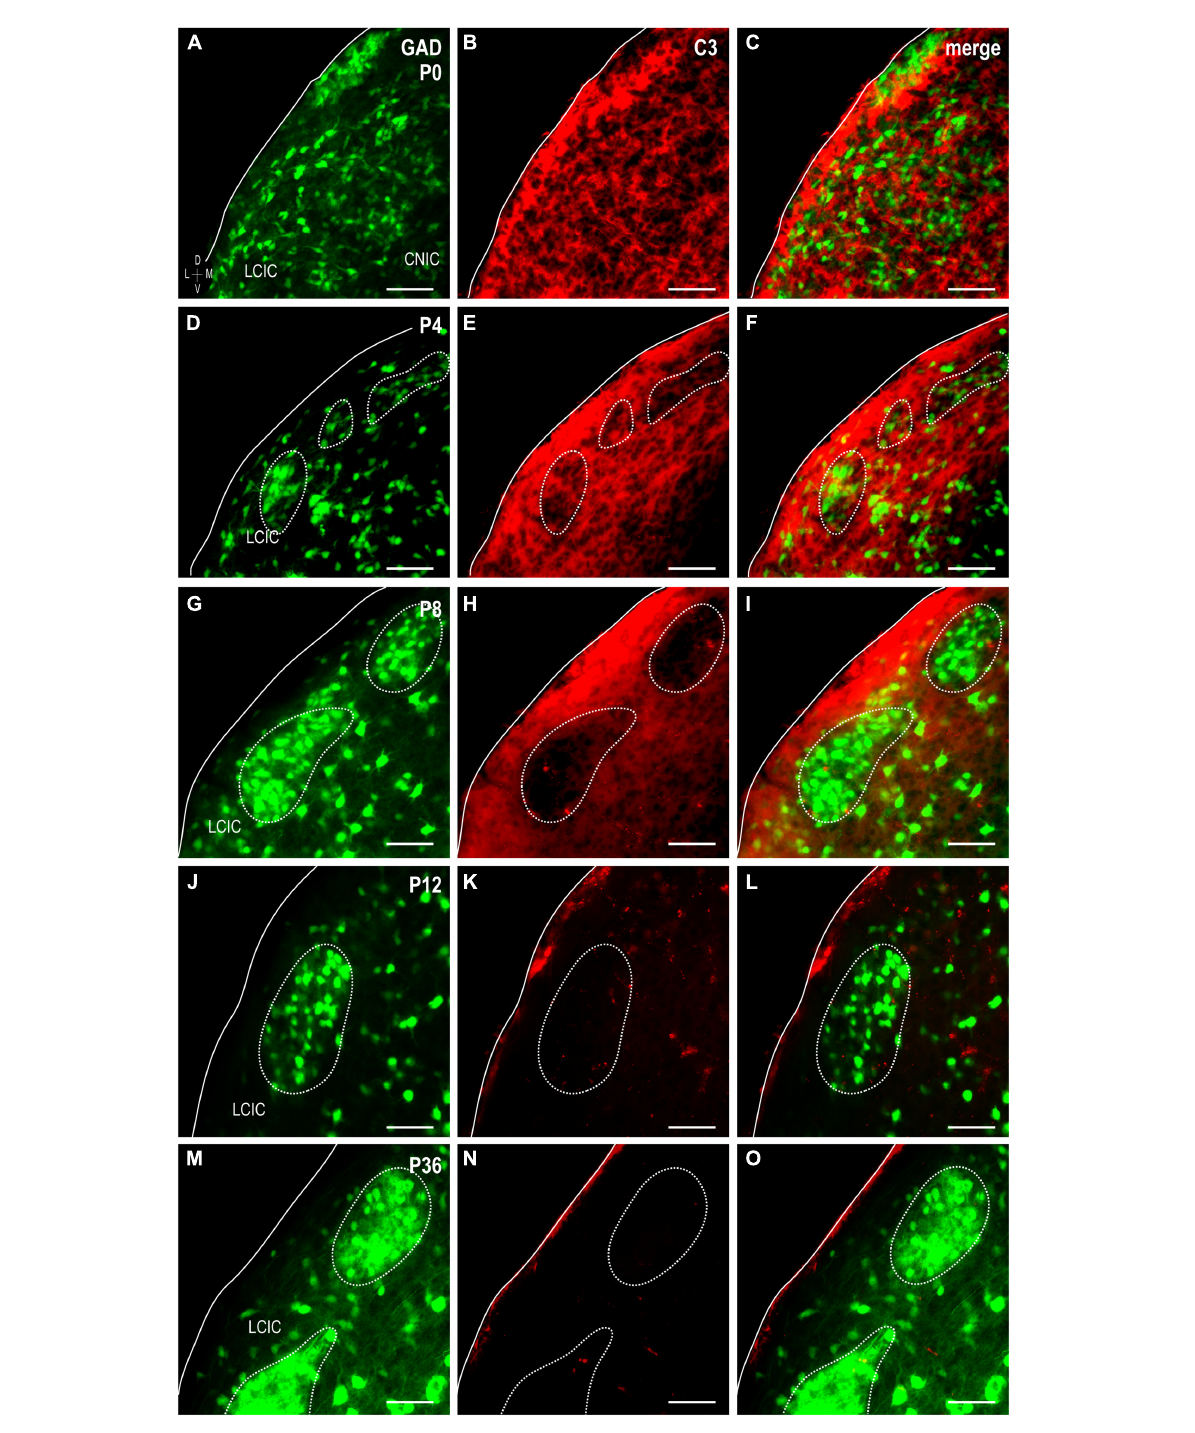
FIGURE1 Complement component 3 (C3) expression (red) in a developmental series [P0, (A–C) ; P4, (D–F) ; P8, (G–I) ; P12, (J–L) ; P36, (M–O) ] of glutamic acid decarboxylase (GAD)-green fluorescent protein (GFP) (green) mice. Hints of GAD-positive lateral cortex of the inferior colliculus (LCIC) modules emerge by P4 and become increasingly apparent with age ( dashed contours ). A diffuse plexus of C3 neuropil expression dominates the LCIC at birth (B,C) , with many of its voids occupied by GAD-positive somata. As LCIC modules begin to organize at P4, the slightest indication of C3 loss is observed within these domains (E,F) . By P8, C3 expression is completely lacking within GAD-defined modular zones, yet remains strongly concentrated throughout the surrounding matrix (H,I) . C3 expression is gone from both LCIC compartments at P12 coincident with its critical period closure (K,L) , and remains so thereafter [P36; (N,O) ]. Scale bars = 50 µ